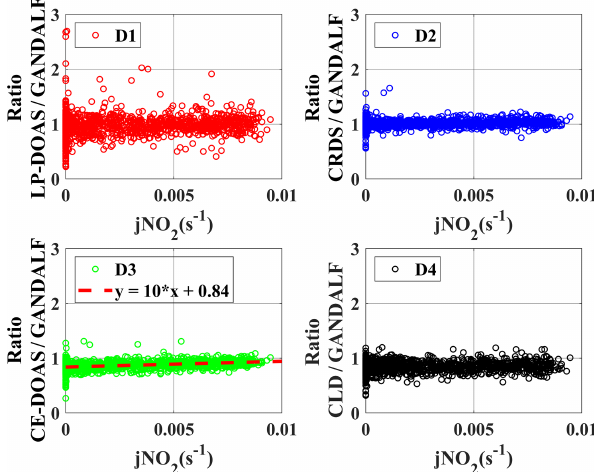
Figure 13. Ratios as a function of measured j NO 2 during PA-